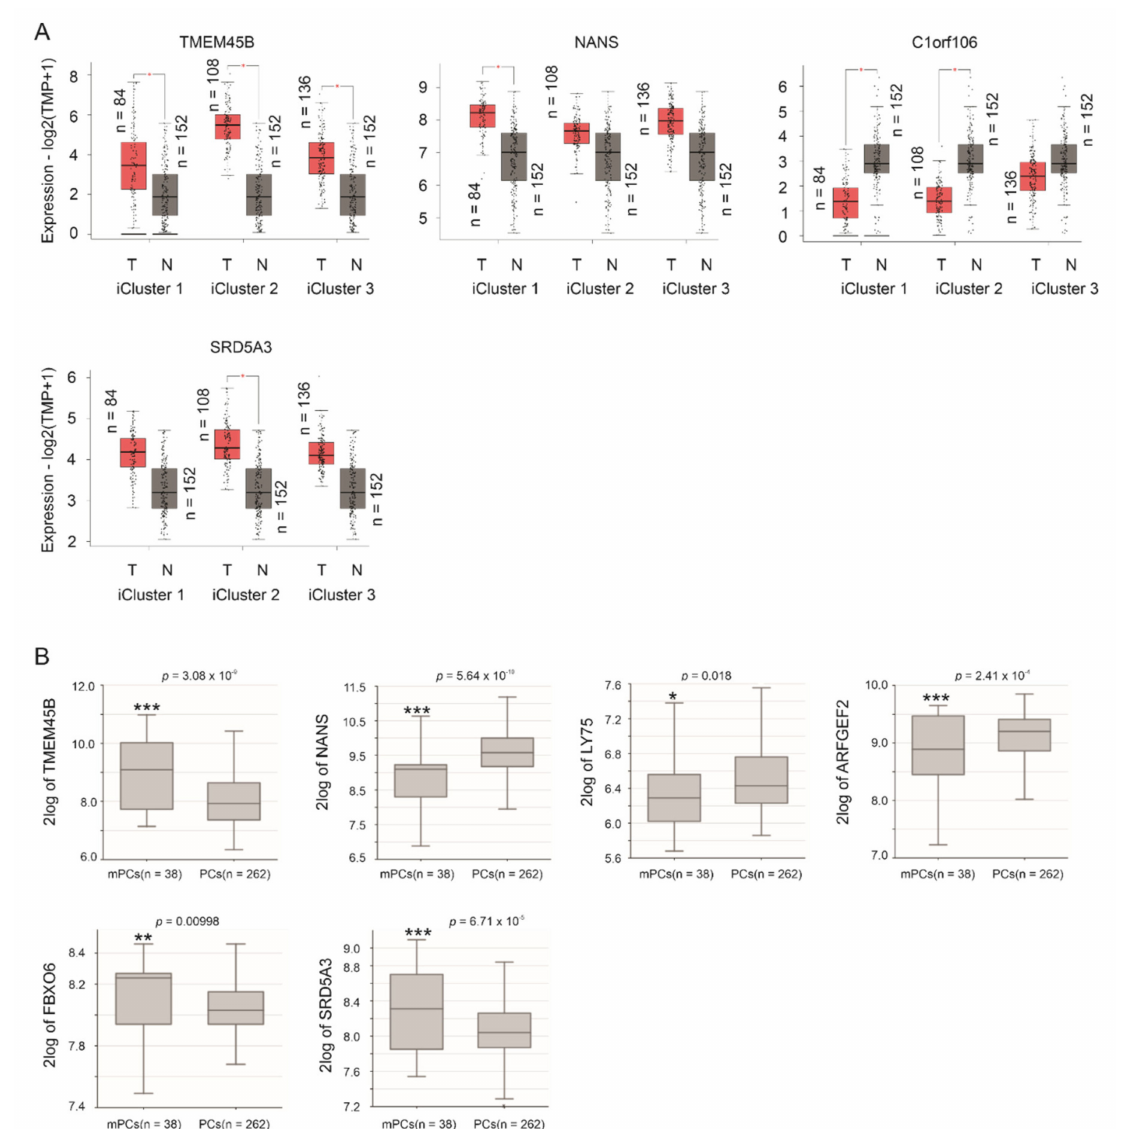
Figure 3. Differential expression of LE genes in PCs and mPCs compared to prostate tissues and primary PCs, respectively. ( A ) The analyses were performed using the GEPIA2 database. T: tumor (PC), N: normal prostate tissues, and TPM: transcripts per million. Statistical analyses were performed by GEPIA2, * p < 0.05. ( B ) Analyses were performed using the Sawyers dataset in R2: Genomics Analysis and Visualization Platform. Expressions were presented as log2-transformed data. Statistical analyses were performed by the R2 Platform using one-way ANOVA. * p < 0.05; ** p < 0.01; *** p <